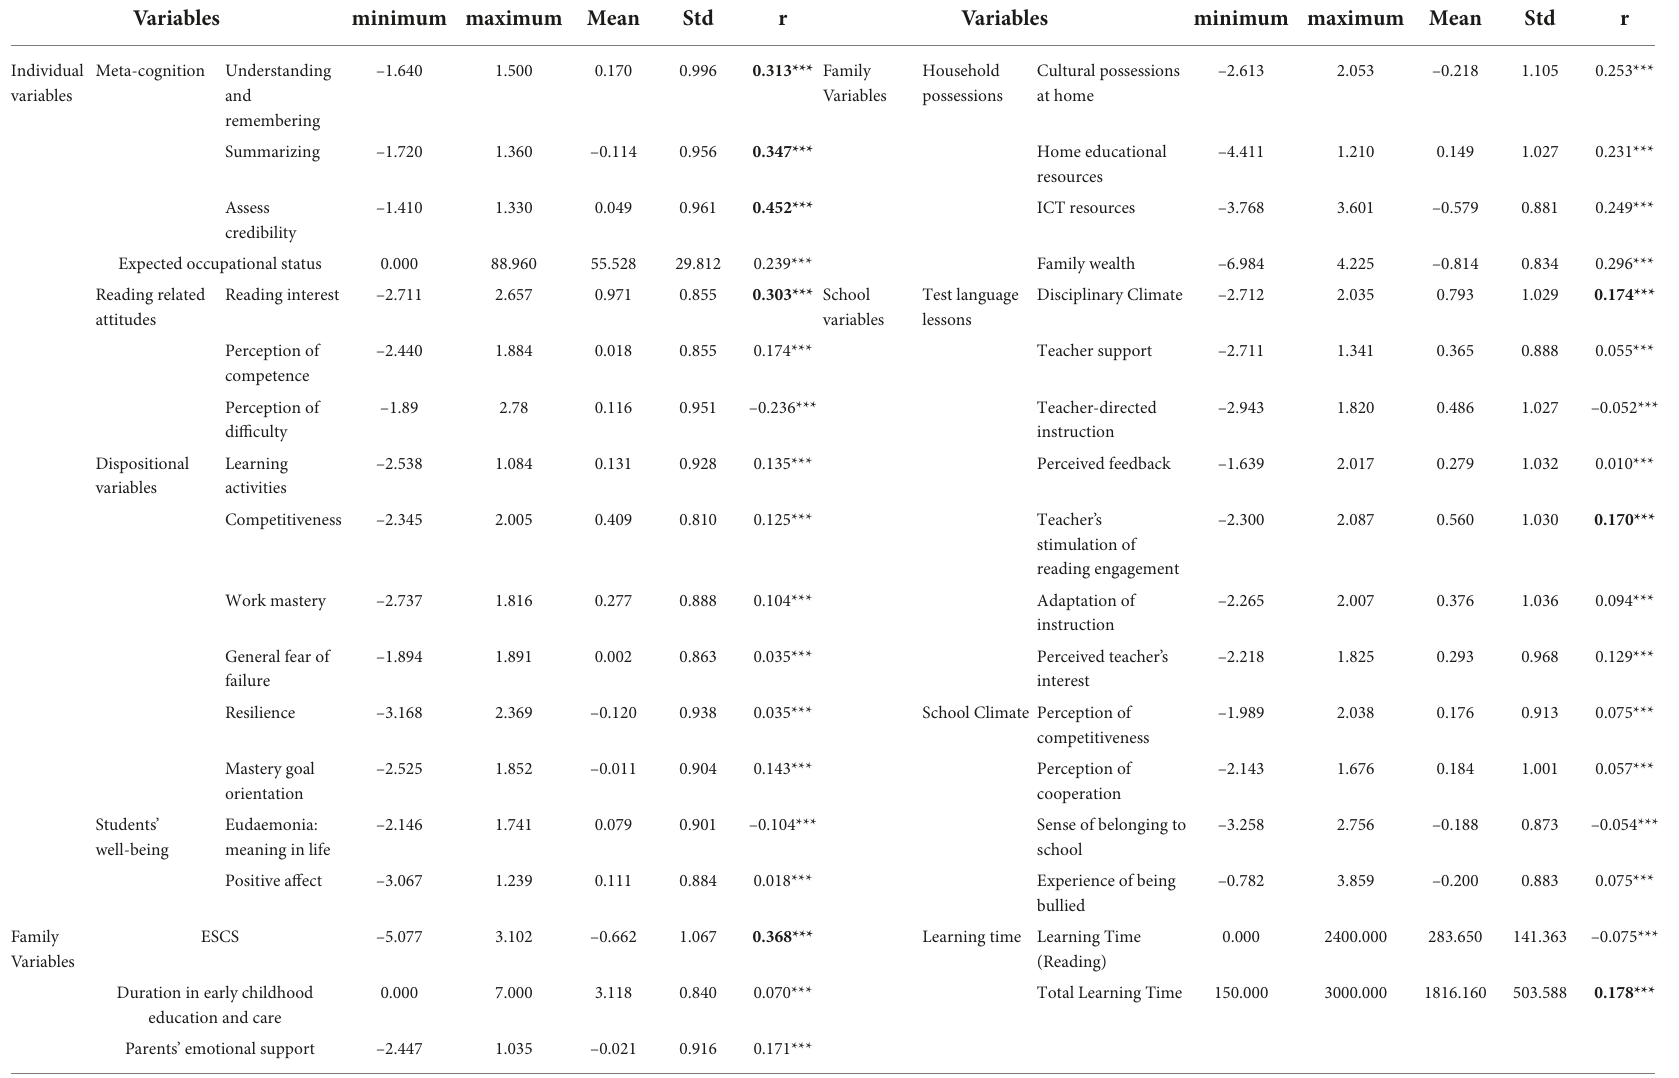
TABLE 1 Descriptive statistics for continuous